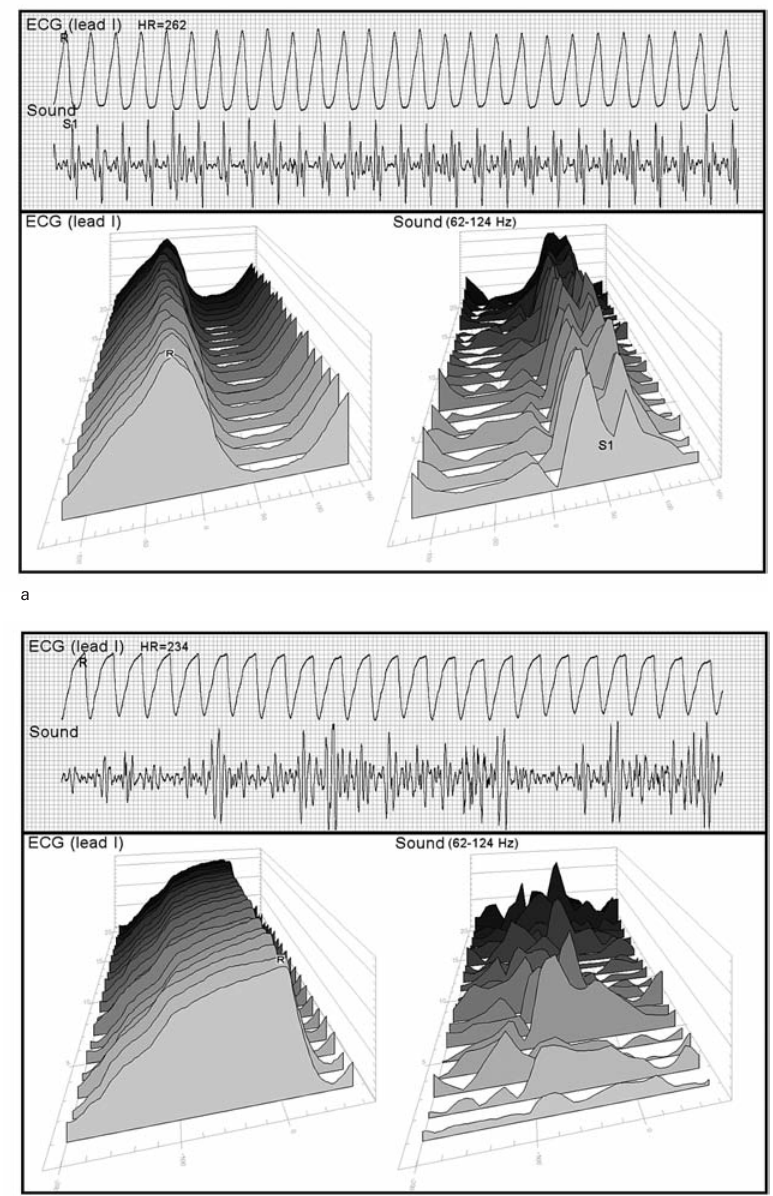
ECG and sound tracings in tachycardia. The upper panel (a) shows an ECG tracing of a rapid wide-complex supraventricular tachycardia. The sound tracing beneath shows that the S1s associated with each beat are both uniform and of high amplitude. The lower panel shows contour maps that also reveal uniformity of both the QRS complexes and the S1s. The lower panel (b) shows an ECG tracing of ventricular tachycardia. The sound tracing beneath shows that the S1s associated with each beat are highly variable and many of them have very low amplitude. The lower panel shows contour maps that also reveal uniformity of the QRS complexes, but marked variability of the S1s. Abbreviations: ECG – electrocardiogram; HR – heart rate; S1 – first heart